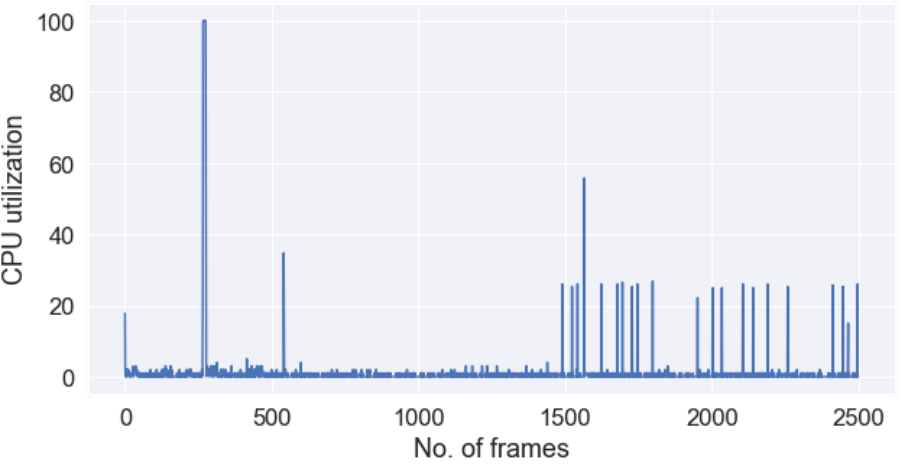
Figure 5. CPU utilization in VM before OpenStack installation.